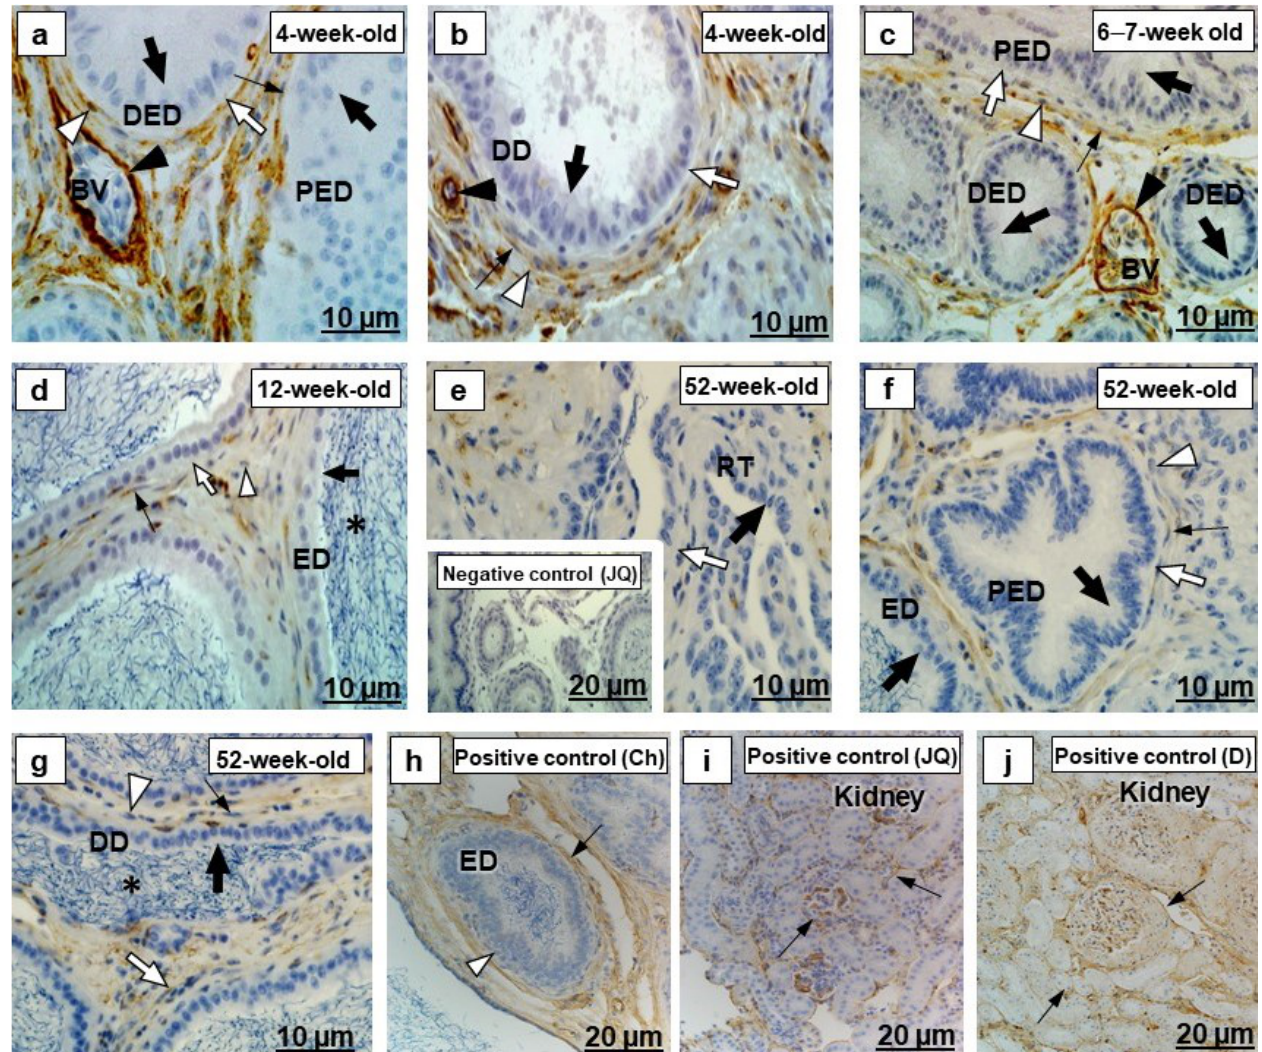
Figure 4. Immunolocalization of fibronectin in the testicular excurrent duct system of Japanese quails ( n = 7 per age group). ( a – g ) Immunonegative epithelia (thick black arrows) and their underlying basement membranes (thick white arrows) of the rete testis (RT), proximal efferent duct (PED), distal efferent duct (DED), connecting duct (CD), epididymal duct (ED) and ductus deferens (DD). ( a – d ) Moderate immunostaining in extracellular matrices associated with smooth muscle cells (thin black arrows) and fibroblasts (white arrowheads). ( a – c ) Black arrowheads depict strong immunos- taining in extracellular matrices connected to endothelial cells of the BV. ( f , g ) Weak immunostaining in extracellular matrices connected to smooth muscle cells (thin black arrows) and fibroblasts (white arrowheads). ( d , g ) Immunonegative spermatozoa (asterisks). Inset ( e ) Negative control: Efferent ducts of an adult Japanese quail. ( h , i ) Positive controls: Thin black arrows indicate immunopositive labeling in peri- and interductal tissues of chicken epididymal duct ( h ), as well as in extracellular matrices of Bowman’s capsules and tubules in the kidney of the adult Japanese quail ( i ) and dog ( j ). ( h ) Immunonegative epithelia of the chicken epididymal duct (white arrowhead). BV, Blood vessel. Ch, Chicken. D, dog. JQ, Japanese